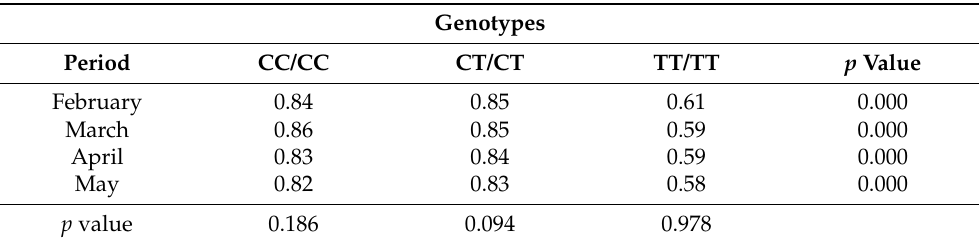
Table 3. Fertility rate in each level of the two variables of the study (period of ram introduction and genotype rs430181568 and rs407388227).